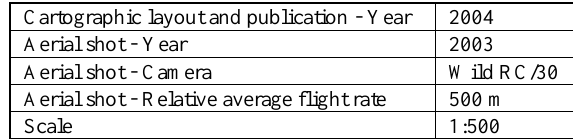
Figure 6. Position of GCPs in the post-earthquake model 3.